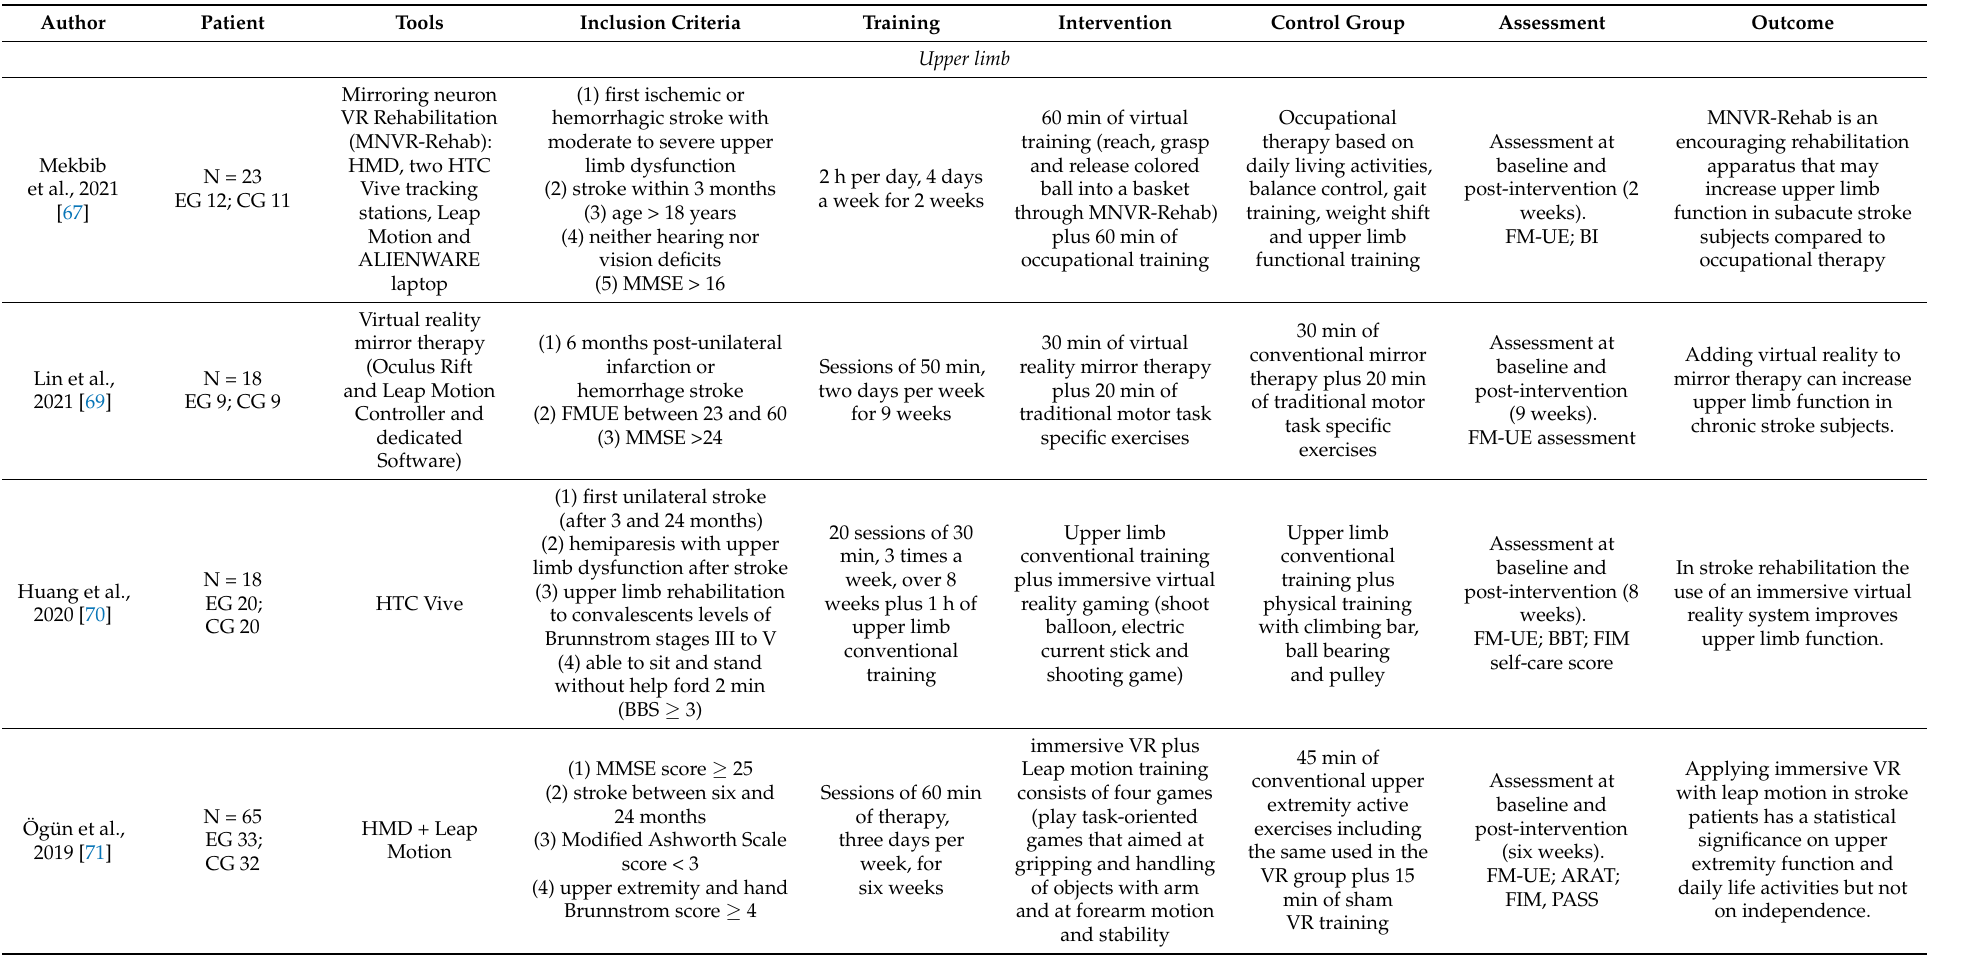
Table 2. Main characteristics of the included